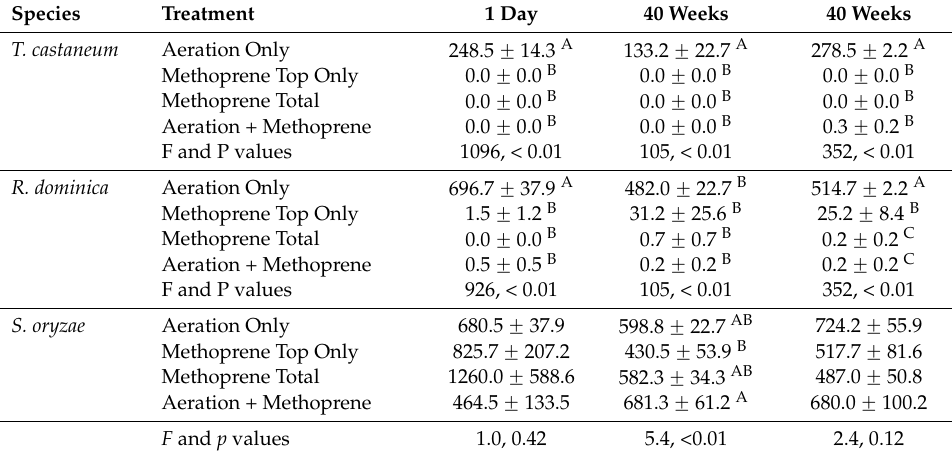
Table 7. Mean numbers ( ˘ SE) of F1 progeny from 50 parental adults of either T. castaneum , R. dominica , and S. oryzae exposed on 100 g of wheat one day after treatment in bins, 20 weeks and 40 weeks after treatment. Means for each species within a column having the same upper case letter, for which there was a significant ( p < 0.05) F-statistic, are not significantly different (LSD test, p < 0.05, SAS Institute, degrees of freedom for analysis within date for treatment were 3, 12).